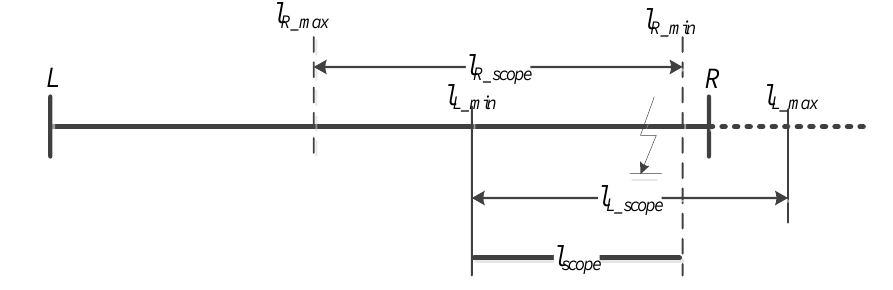
Figure 10. Intersection of two scopes.